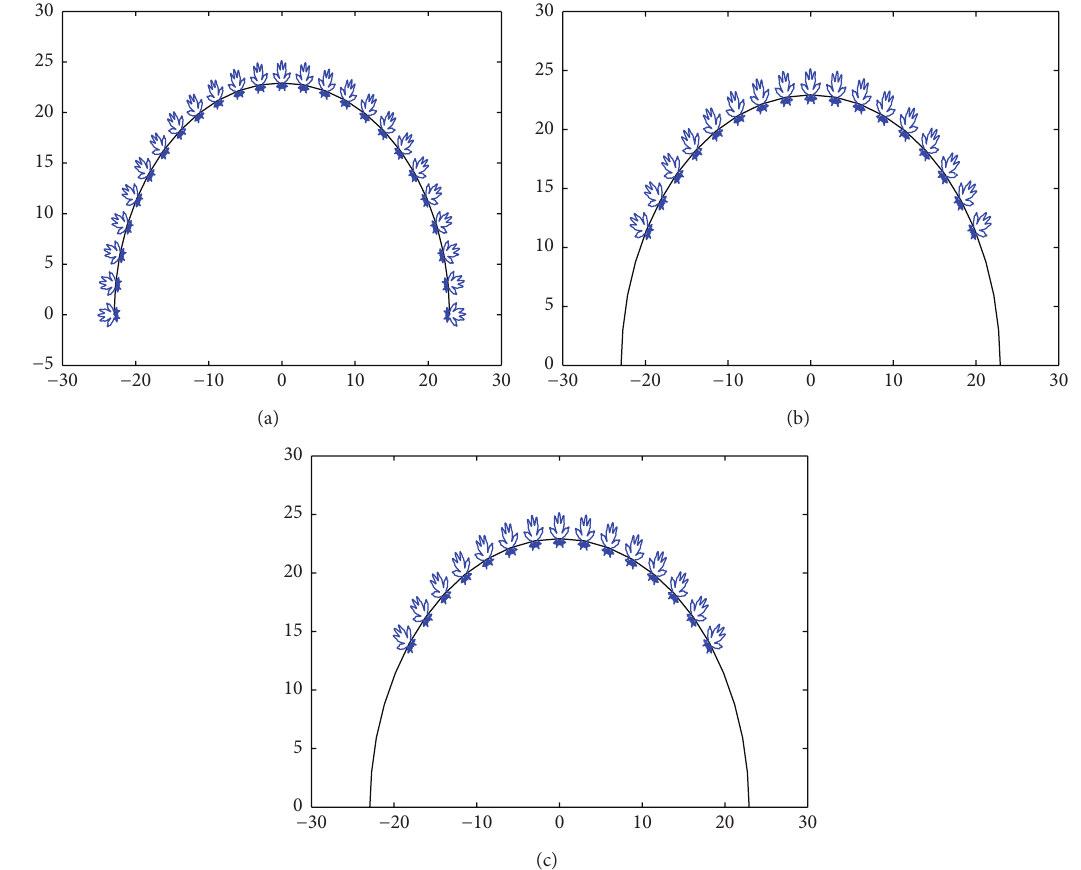
Figure 12: (a) All elements. (b) Active elements selection in Step 1 . (c) Active elements selection in Step 2 .